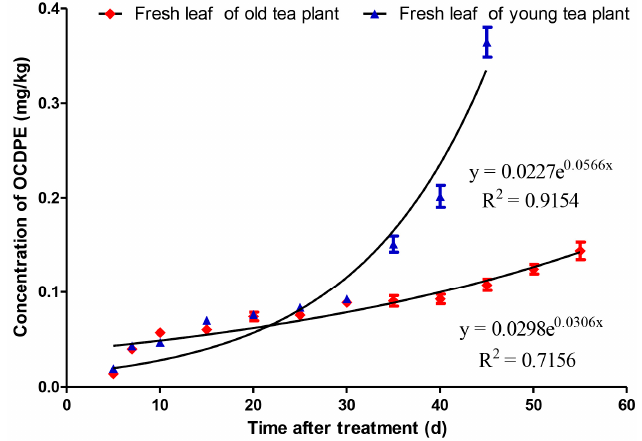
Figure 3. The accumulation curve of OCDPE in the fresh leaves of young and old tea plants (n = 3).